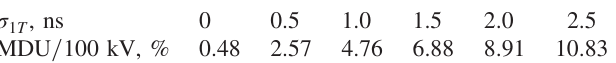
FIG. 8. With green and red the regions are shown where the top of the pulse at the output of the LTD module has larger variation (red) or smaller (green) than (cid:1) 0 . 5 % for σ 1 C = separating these two regions, the top of the output pulse is (cid:1) 0 . 5 % flat. Red points on the green section of this graph indicate how the red region would increase (and the green decrease) if the tolerance of the capacitor capacitance σ 1 C = cluded in